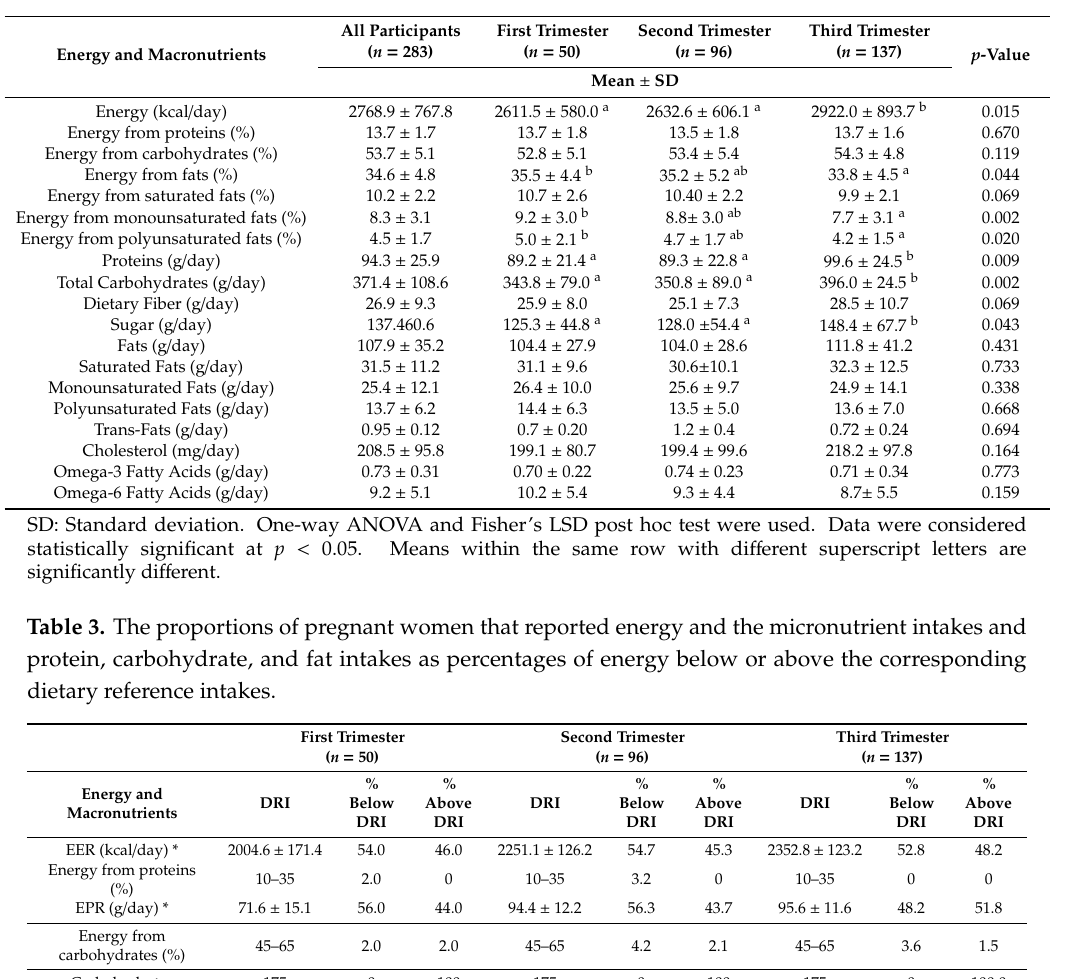
Table 2. The mean daily intakes of energy and macronutrients estimated by a validated food frequency questionnaire administered to 283 pregnant Jordanian women.